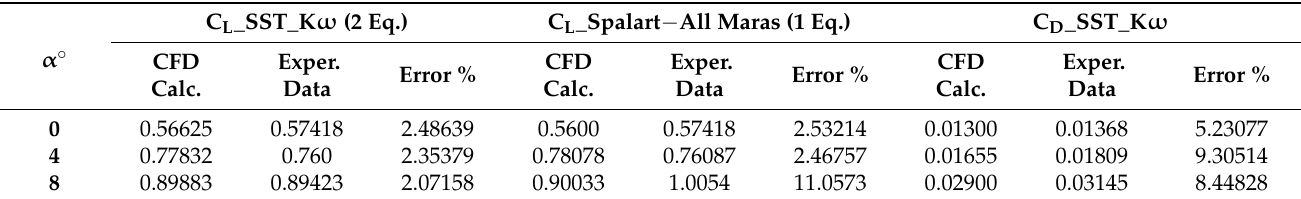
Figure 6. Comparisons between the computational fluid dynamics (CFD) calculated and experimentally determined pressure distributions for TEF airfoil with angles of attack of 0°: ( a ) C L distribution; ( b ) C D distribution; ( c ) C P distribution. Table 2. Comparisons between CFD results and experimental data for the TEF airfoil.